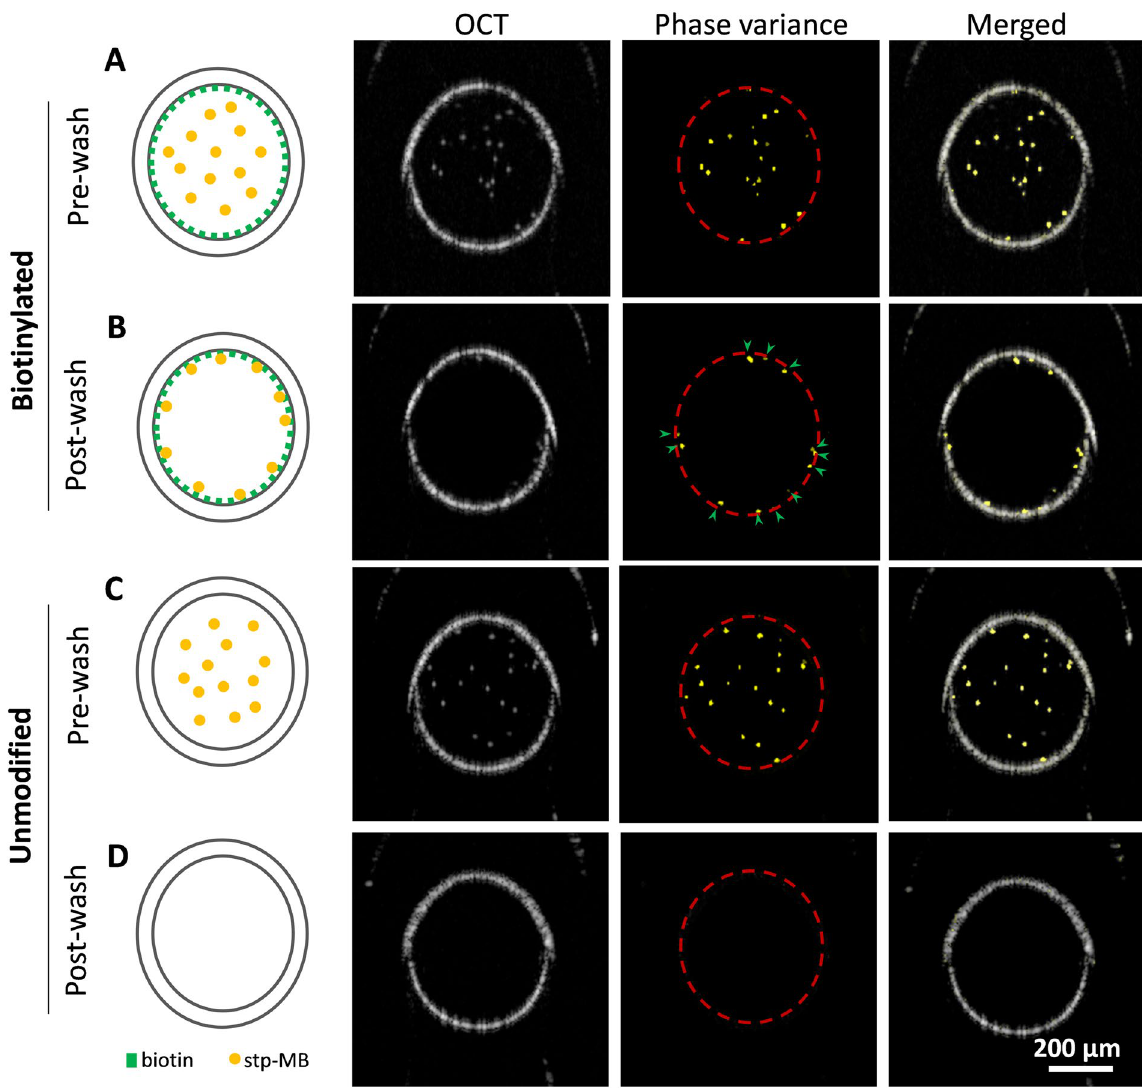
Figure 2. OCT scattering and phase variance signals of flowing and target-bound µ Bs in biotinylated ( A , B ) and unmodified ( C , D ) capillary tubes before ( A , C ) and after ( B , D ) wash. Columns from left to right: (1) Illustrations of the capillary tube modification and distributions of stp- µ Bs inside the capillary tubes, (2) OCT B-scan images showing the OCT scattering signals of stp- µ Bs and the reflections from the capillary tube glass/ water interfaces, (3) detected phase variance signals (the glass/water interfaces are marked by red dashed lines) and (4) Superimposition of the detected phase variance signals on the OCT B-scan